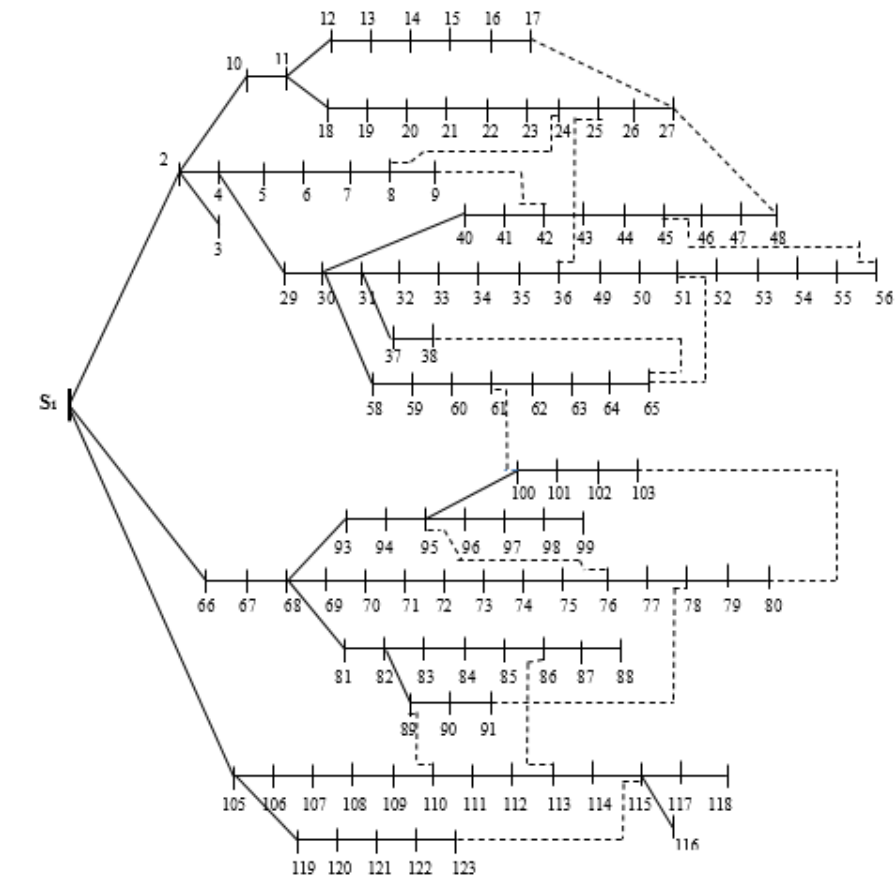
Figure 10. IEEE 119-bus network configuration. Table 8. The optimal results obtained via different optimizers applied to the IEEE 119-bus.